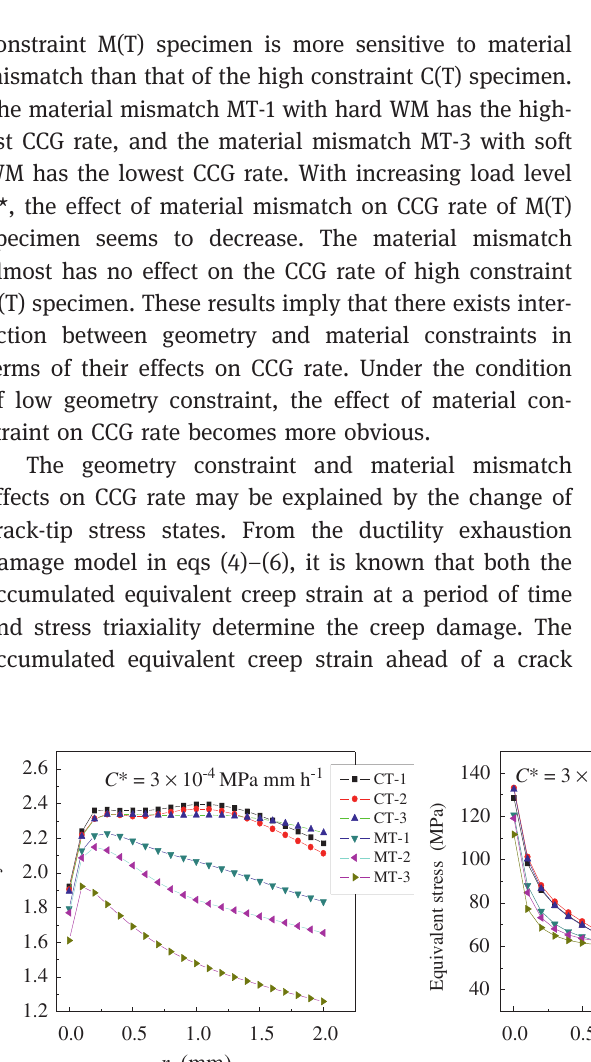
Figure 6: The distributions of stress triaxiality (a) and equivalent stress (b) ahead of crack tips at a typical C * value of 3 × 10 − 4 MPamm h – 1 for C(T) and M(T)